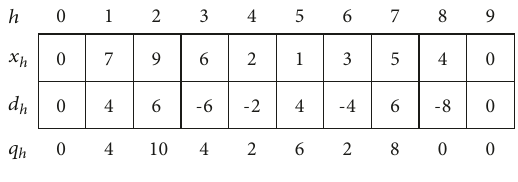
Figure 2: Solution